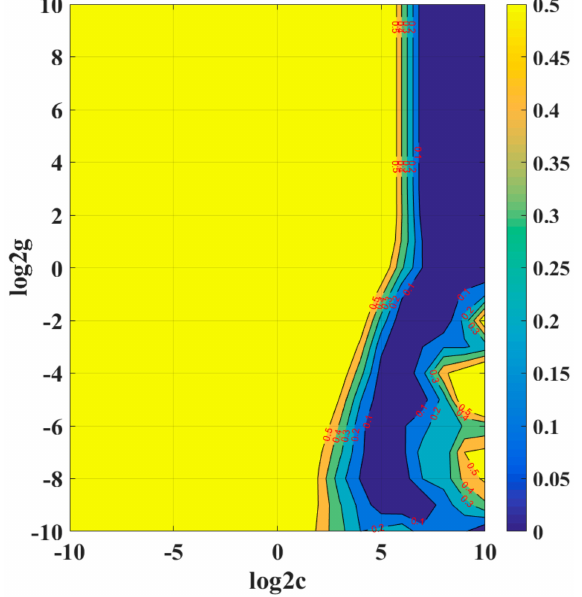
Figure 9. Determination of optimal parameters using a progressive search algorithm when the lower value prediction is carried out.